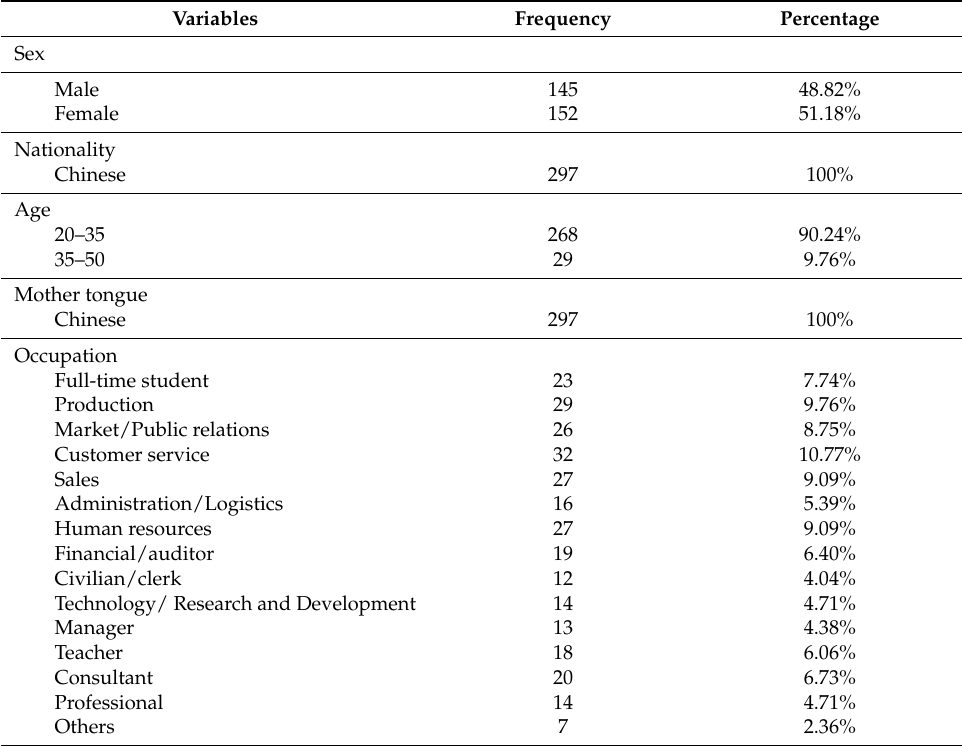
Table 3. Demographic information of respondents (N =